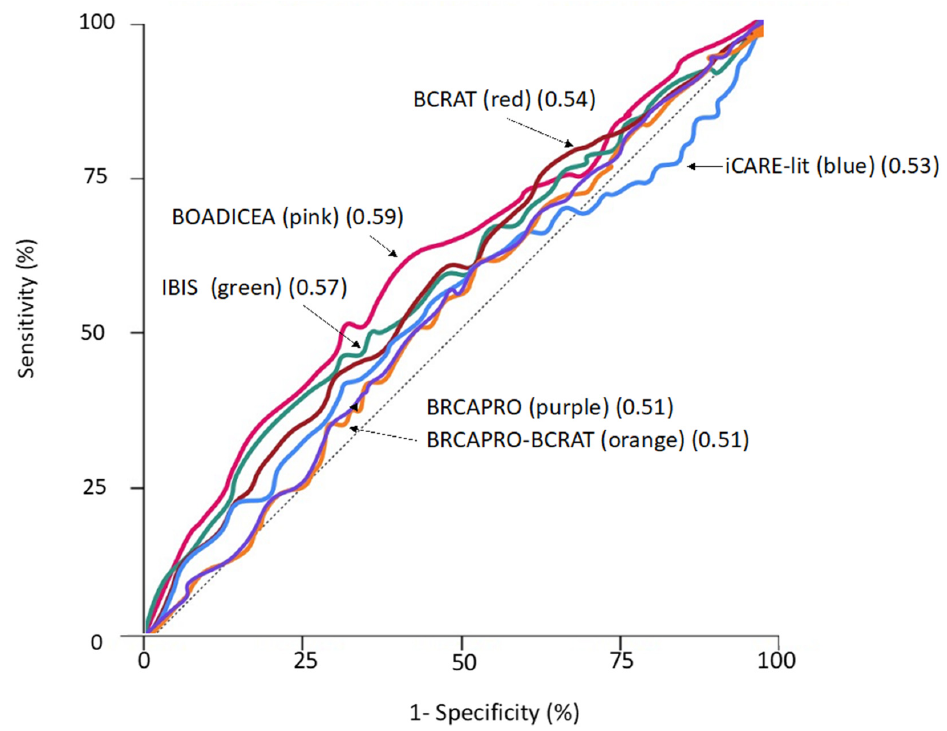
Figure 1. Receiver operating characteristic curves for six risk models. C-statistics are denoted in brackets. The dotted line denotes represents the line of no discrimination.